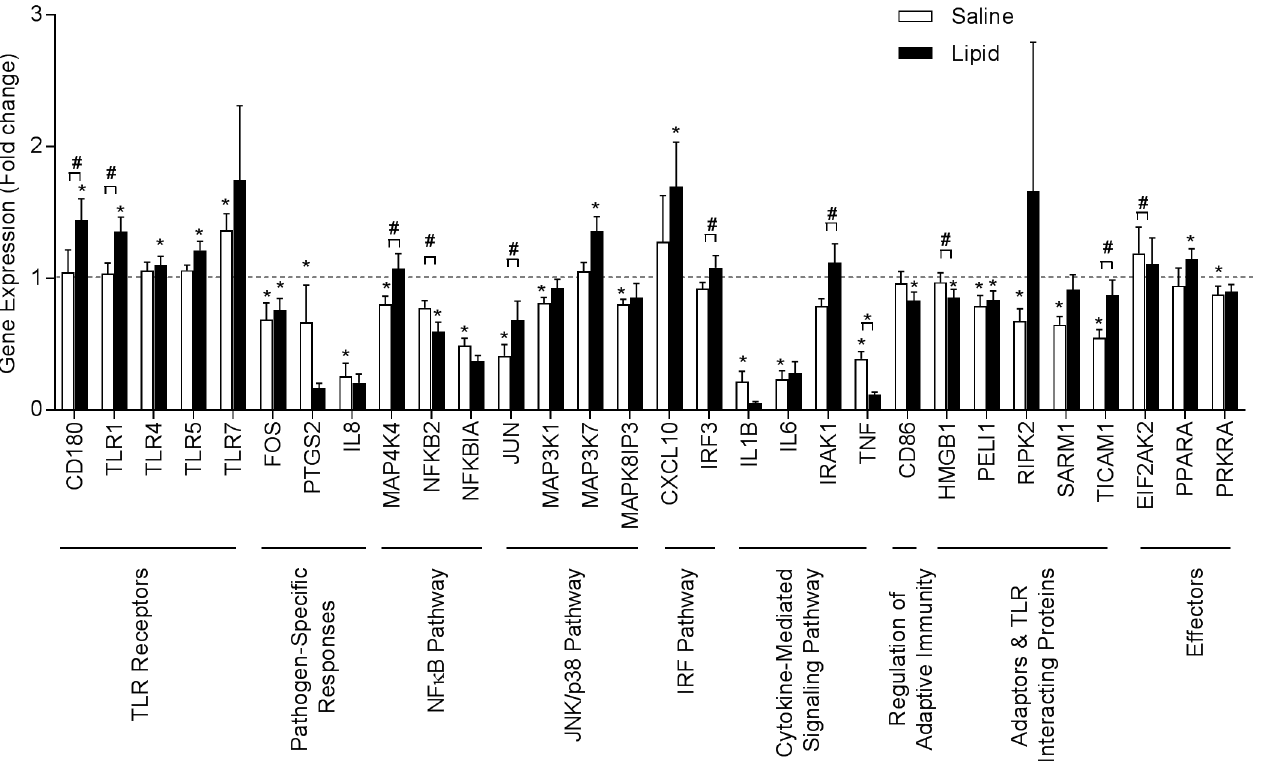
Fig 2. Effects of lipid infusion on expression of genes in the TLR signaling pathway in peripheral blood monocytes. Expression of 84 genes central to TLR-mediated signal transduction was determined using a human TLR Signaling Pathway RT 2 Profiler PCR Array as described under ‘Materials and methods’. All values are mean ± SEM of data obtained from 12 subjects. (cid:3) P < 0.05 pre- vs. post-infusion within group; # P < 0.05 post-saline vs. post-lipid.